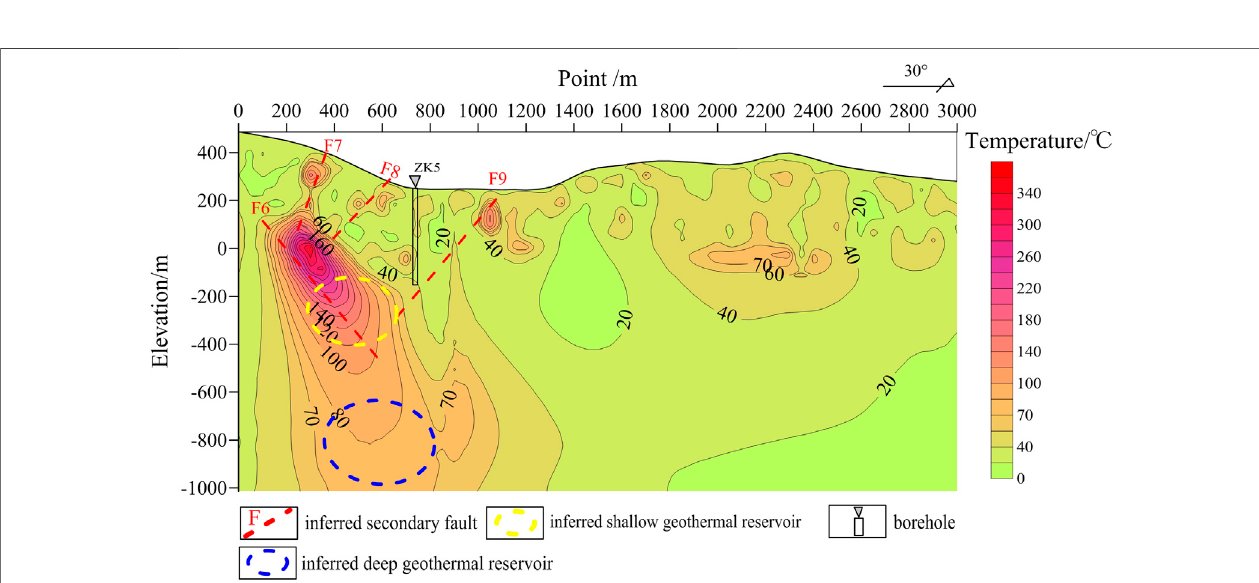
FIGURE 9 | Temperature section of survey line